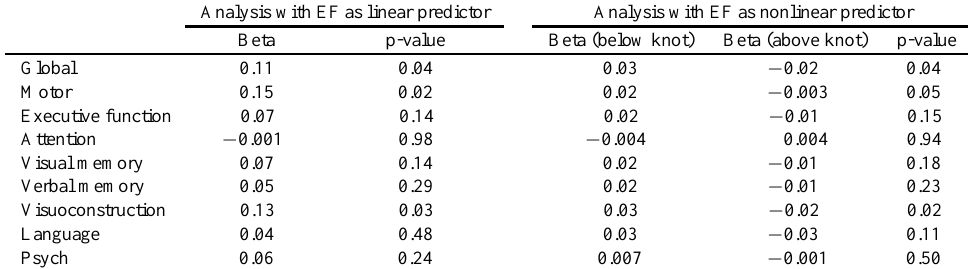
Table 3 Regression coefficients for each of 8 cognitive domains. The coefficient in the first column represent the change in the age, sex, and education-adjusted Z-score for each 10% increase in cardiac ejection fraction (EF), with EF analyzed continuously as a linear